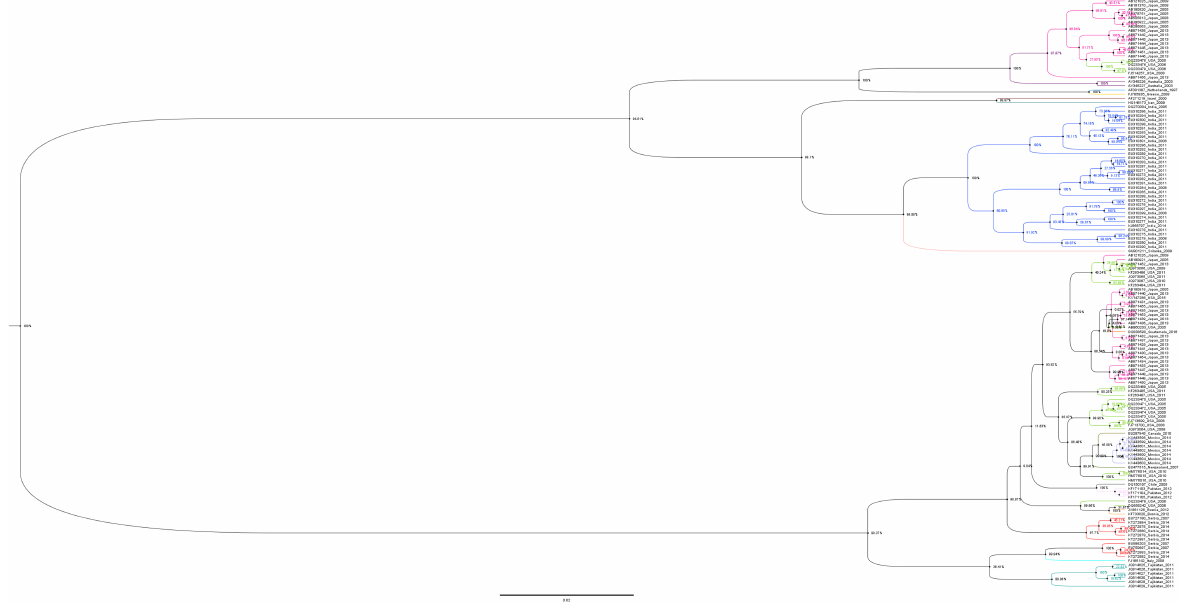
FIGURE 6 | Maximum Clade Credibility (MCC) tree of Iris yellow spot orthotospovirus (IYSV) nucleocapsid (N) gene (nucleotide sequences) generated in BEAST v2.4.6. Nodes of IYSV isolates reported from different countries are